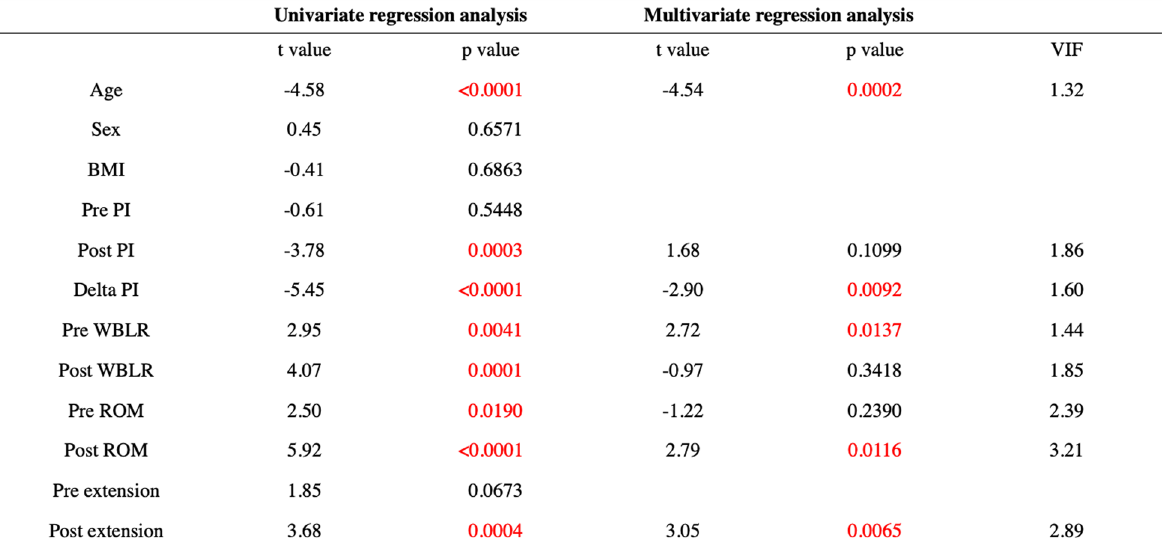
Table 3 Regression analyses of the factors affecting the postoperative clinical outcome